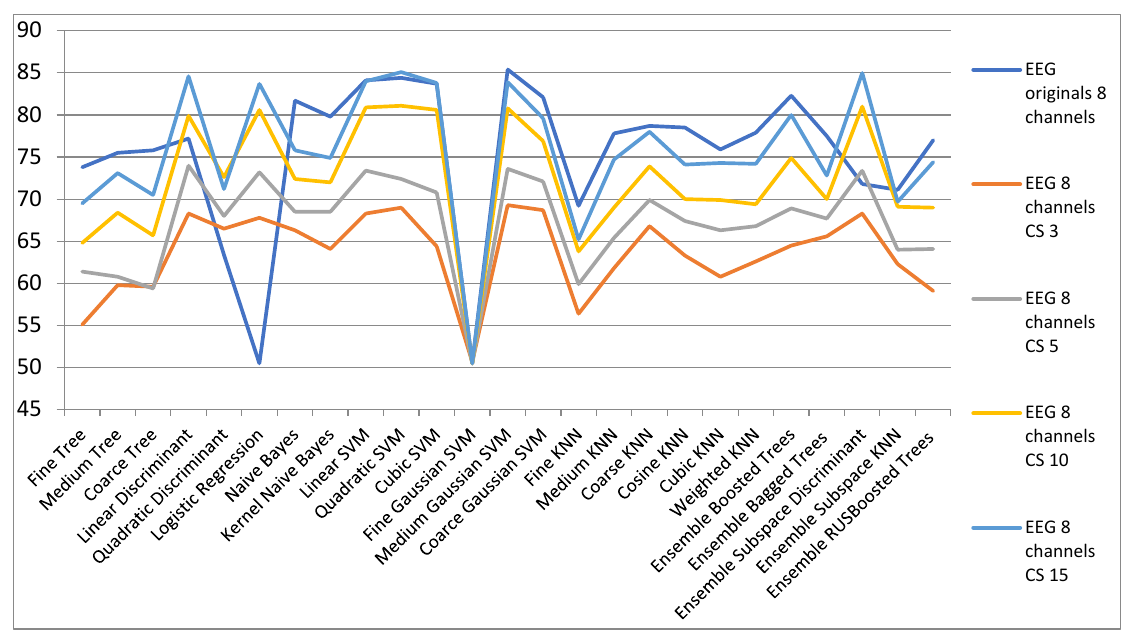
Figure 11. Results for the dimensionality reduction with CS algorithm for configurations with 8 channels. Table 5. Classification results with CS method for configurations with 8 channels. ECG Orig.